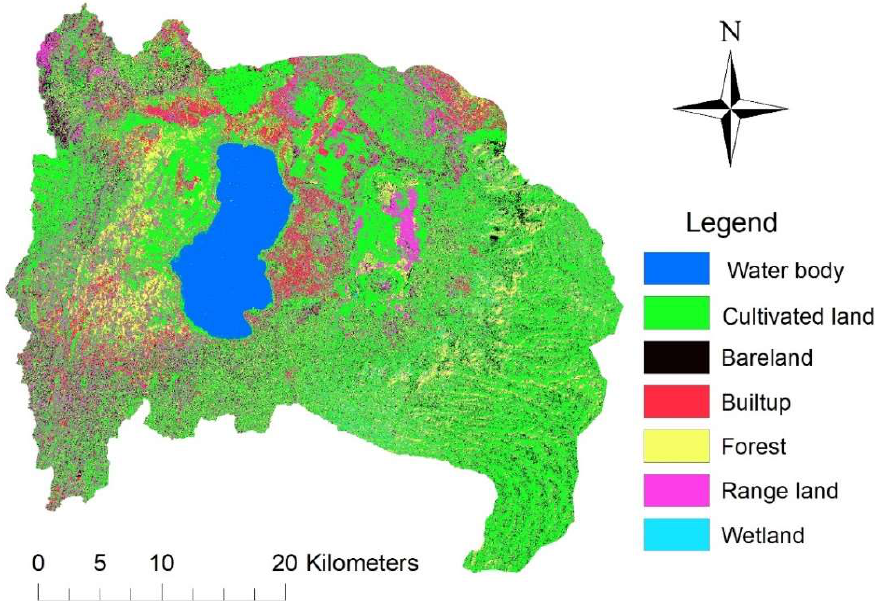
Figure 2. Land Use map of Lake Hawassa Watershed.